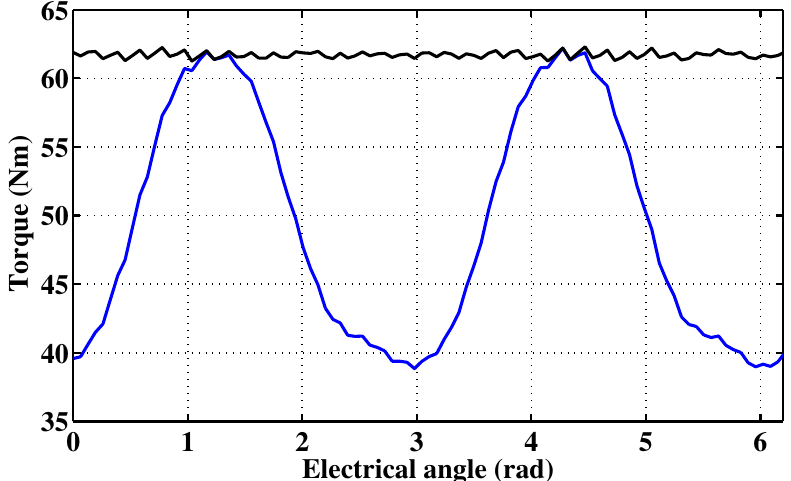
Figure 19. Torque-angle characteristics for the coil rated current rms value of 14 A in the case of the conventional armature winding arrangement. Legend: (blue) faulty scenario corresponding to the case of a passive phase, (black) healthy